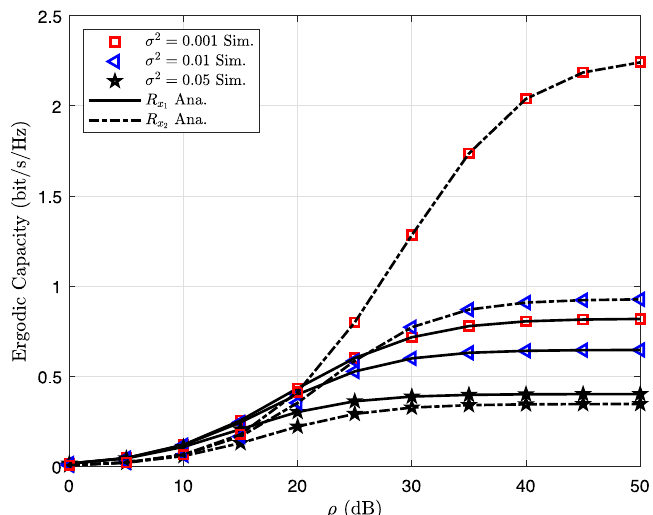
Fig. 7 Ergodic capacity vs ρ (dB) varying σ 2 with the satellite link under HS